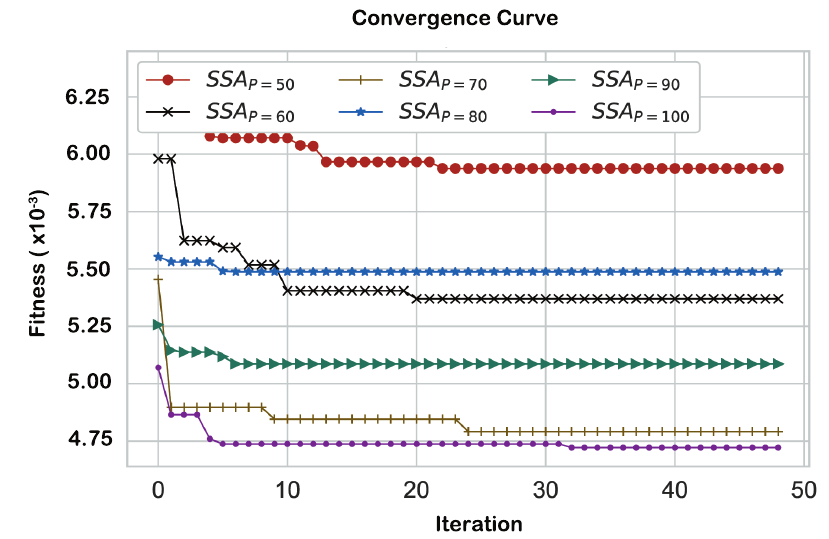
Figure 11. Convergence curves of the SSA algorithm at different population sizes.